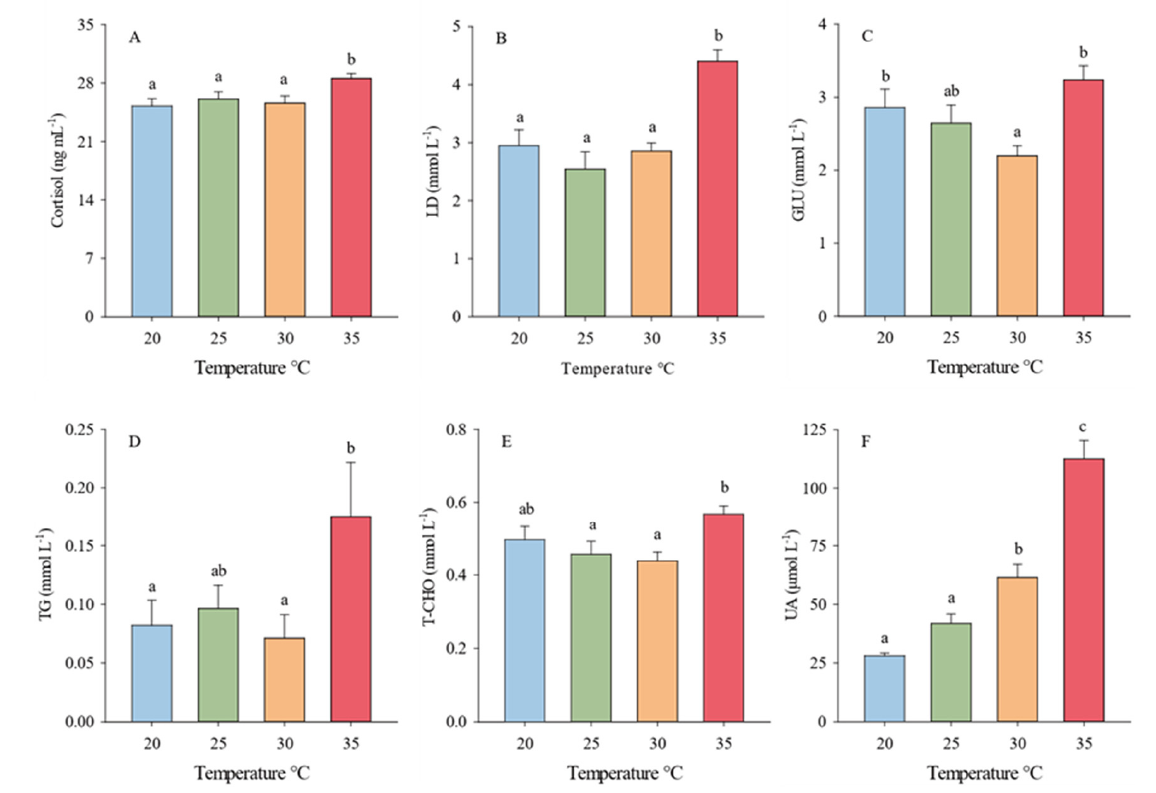
Figure 8. Effects of different temperatures on cortisol ( A ), lactic acid (LD) ( B ), glucose (GLU) ( C ), triglyceride (TG) ( D ), total cholesterol (T-CHO) ( E ), and uric acid (UA) ( F ) content in juvenile mud crabs. Values are presented as mean ± SD ( n = 3). Different superscripts indicate significant differences between treatments ( p < 0.05).